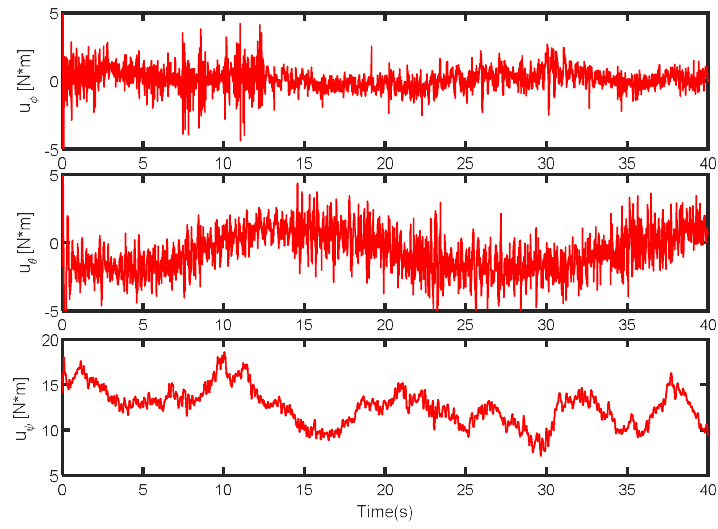
Figure 14. Control inputs using SMC. Table 5. Quantitative analysis between proposed method and SMC in experiments.